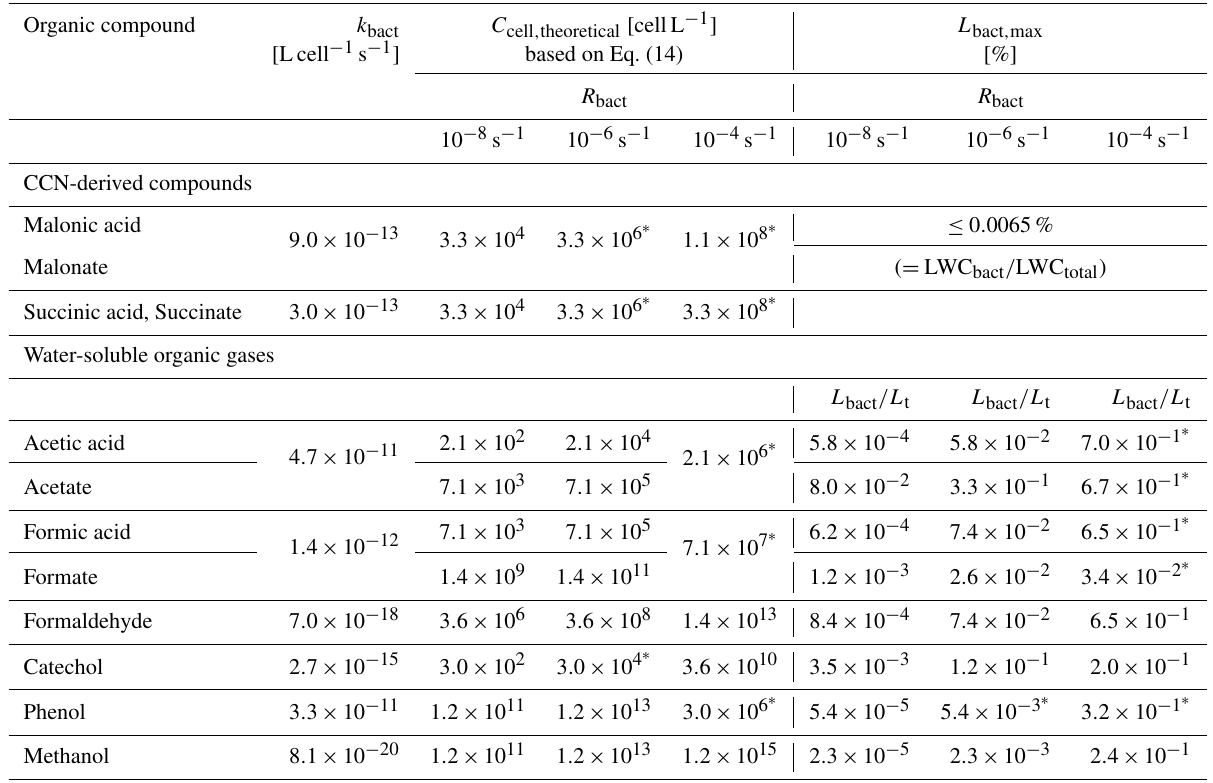
Table 3. k bact [cellL − 1 ] calculated from literature data, theoretical C cell [cellL − 1 ] based on Eq. (14), and the ratio L bact /L t for three R bact values (10 − 8 , 10 − 6 and 10 − 4 s − 1 ) for water-soluble organic gases and CCN-derived compounds. Values with ∗ show bacterial concentrations that are realistic for cloud